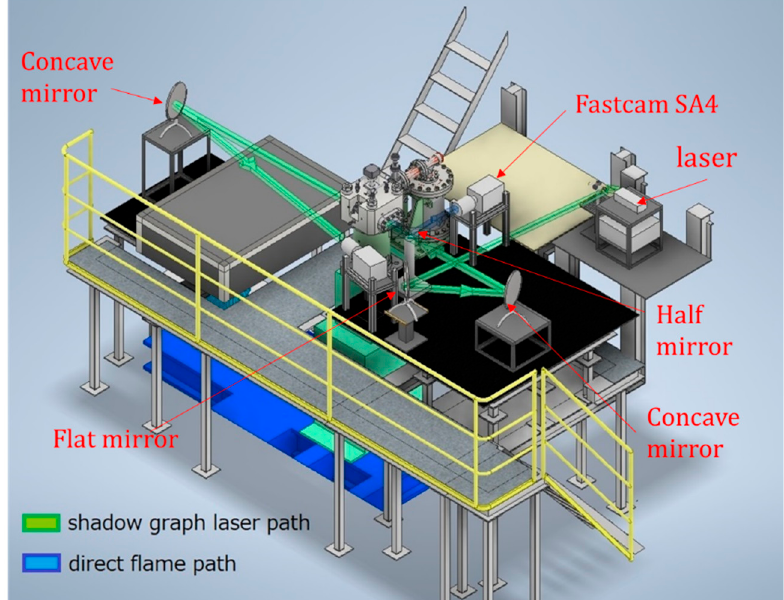
Figure 6. Experimental layout: ( a ) front picture of RCEM ( b ) RCEM schematic.